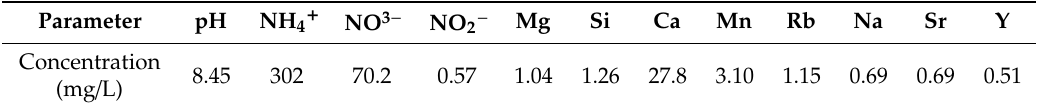
Table 1. Characteristics of actual